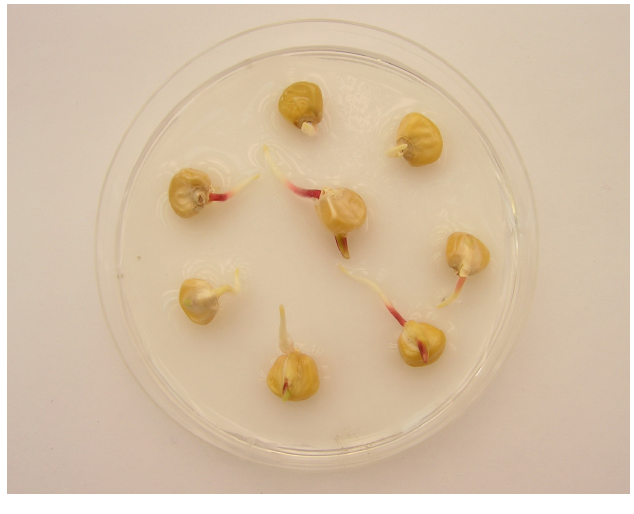
Figure 6. An illustrative example for maize growth and development experiments under juglone-stressed